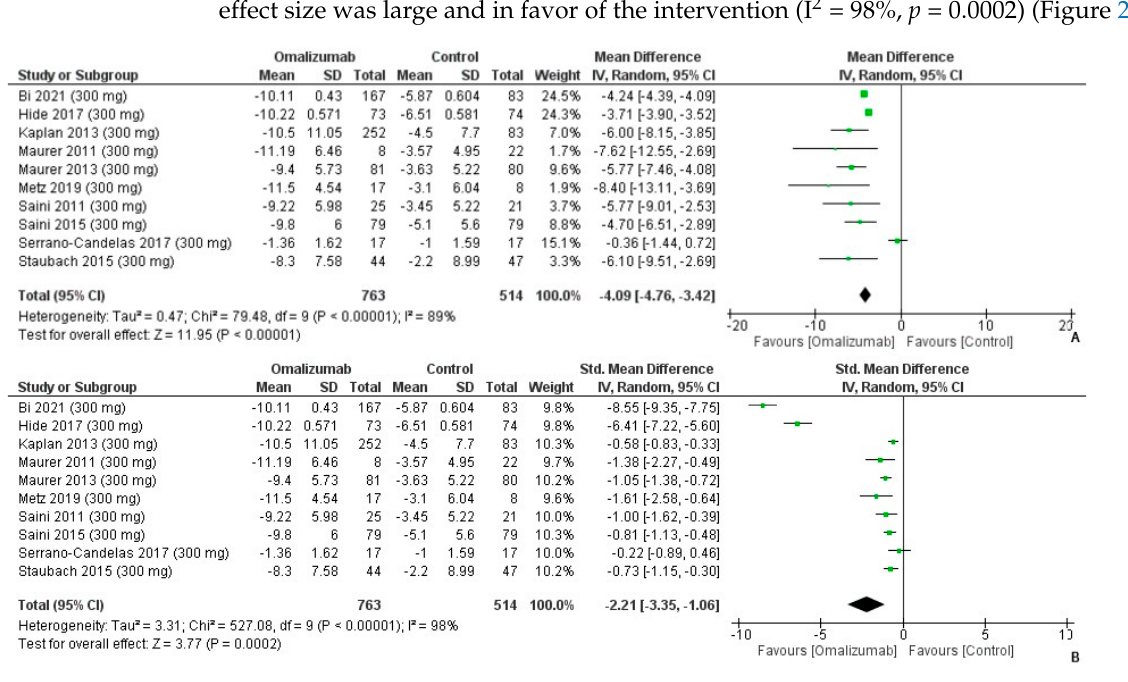
Figure 4. Weekly Itch Score Outcomes with 300 mg dosage of omalizumab [17 − 26]. ( A ): Mean dif- Figure 2. Weekly Itch Score Outcomes with 300 mg dosage of omalizumab [17–26]. ( A ): Mean ference: − 4.09 [95% CI: − 4.76, − 3.42]; Heterogeneity: Tau² = 0.47; Chi² = 79.48, df = 9 ( p < 0.00001); I² = 89%; Test for overall effect: Z = 11.95 ( p < 0.00001). ( B ): Standardized mean difference: − 2.21 [95% CI: − 3.35, − 1.06]; Heterogeneity: Tau² = 3.31; Chi² = 527.08, df = 9 ( p < 0.00001); I² = 98%; Test for overall effect: Z = 3.77 ( p = 0.0002).